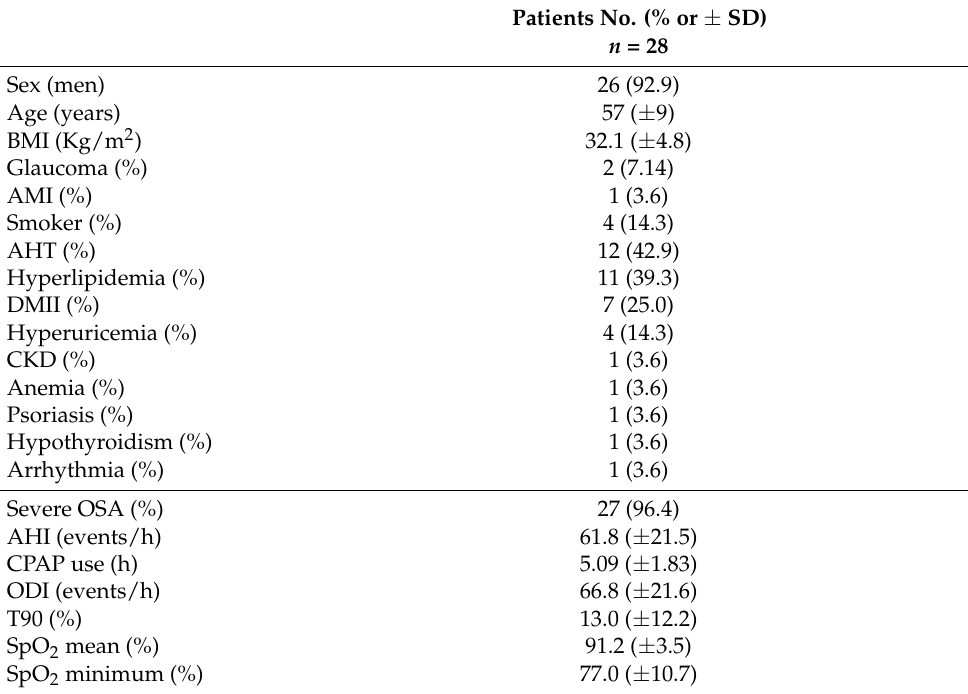
Table 1. Baseline characteristics of the patients with obstructive sleep apnea included in this study.